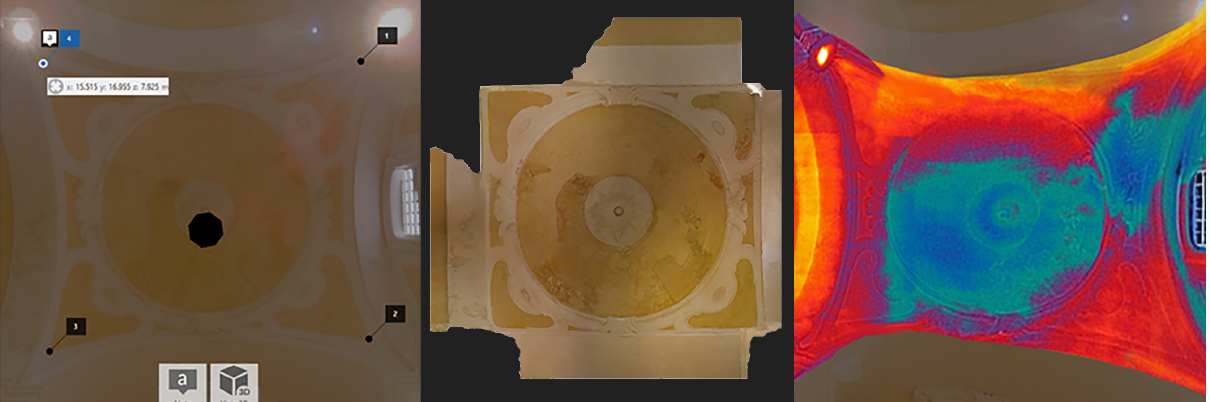
Figure 6. Dome acquisition using range-based, image-based, and IR thermography